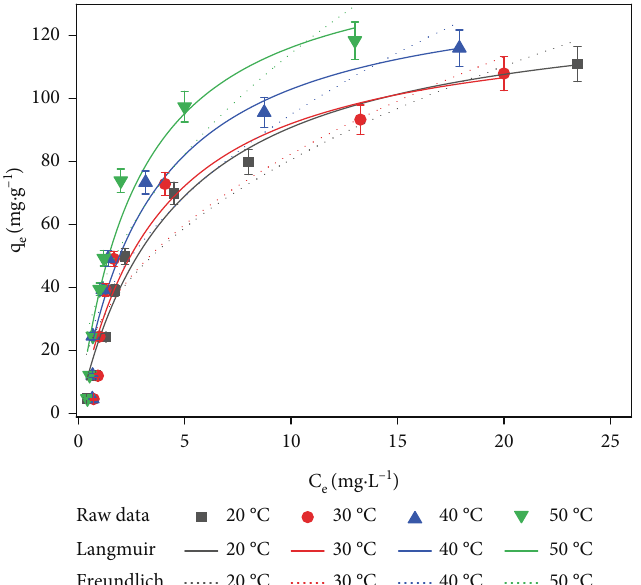
Figure 11: The Langmuir and Freundlich isotherm models for the adsorption of BF dye on TKC at di ff erent temperatures (0.1 g TC, initial pH = 6 : 0 ). Table 2: Isotherm parameters for the adsorption of BF dye onto TKC adsorbent. Isotherm models Isotherm